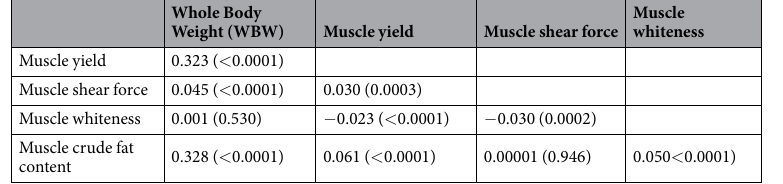
Table 2. Pairwise comparison showing correlation between different growth and muscle quality phenotypes. Correlation was calculated from phenotypic data of ~500 individual fish of USDA-ARS-NCCCWA’s growth selected line used in this study. Table shows correlation coefficients (R 2 ) between each pair of traits and p value inside the brackets. Negative ( − ) value indicates negative